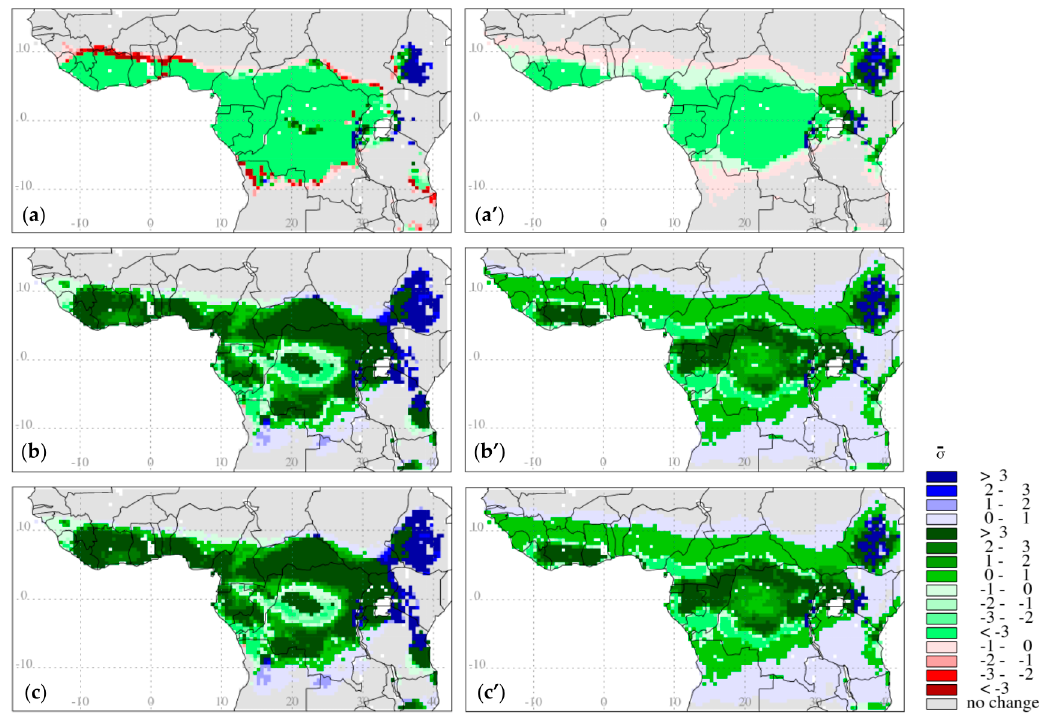
Figure 9. Changes in biomass per unit area (g C m − 2 ) between 2080–2099 and the reference 1980–1999 period. Biomass change for the species Ceiba pentendra . The magnitude of change is expressed as a multiple of the spatial average of the 1980–1999 biomass standard deviation σ (704 g C m − 2 ) over the species current distribution area [48]. Biomasses correspond here to the ensemble mean of the results obtained with the seven climate projections under the RCP8.5 scenario and with species-specific morpho-physiological traits. Three different atmospheric CO 2 configurations are tested: ( a ) a CO 2 constant [330], ( b ) a CO 2 variable downregulated [down], and ( c ) a CO 2 variable [var]. Disappearance of species is indicated in red, expansion in blue and preservation in green colors. Biomass increase and decrease over the preserved range are respectively in dark and light greens. ( a’ , b’ , c’ ) the same for Musanga cecropioides with a 𝜎 of 828 g C m − 2 . See Supplementary S5 for all the species.